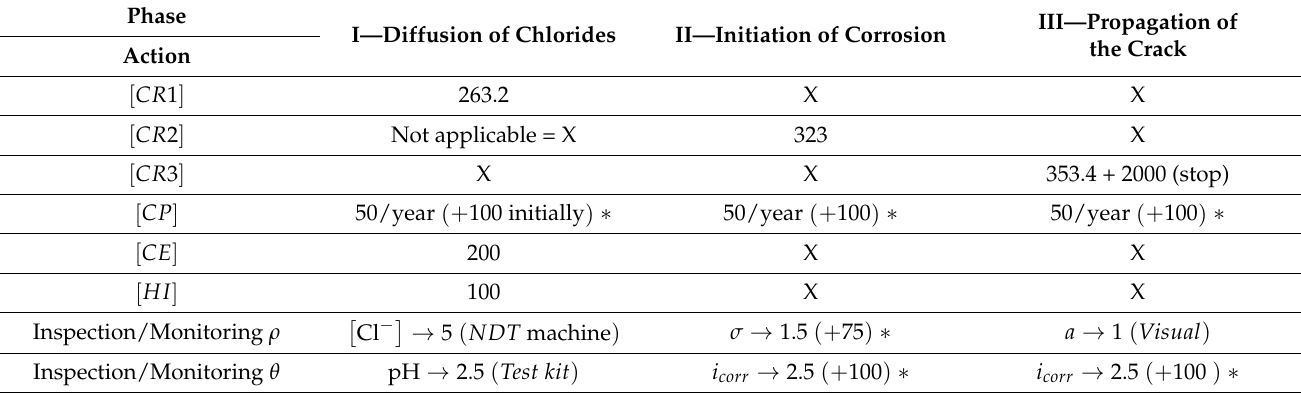
Table 4. Costs of maintenance actions and inspections per phase ( € /m 2 ).